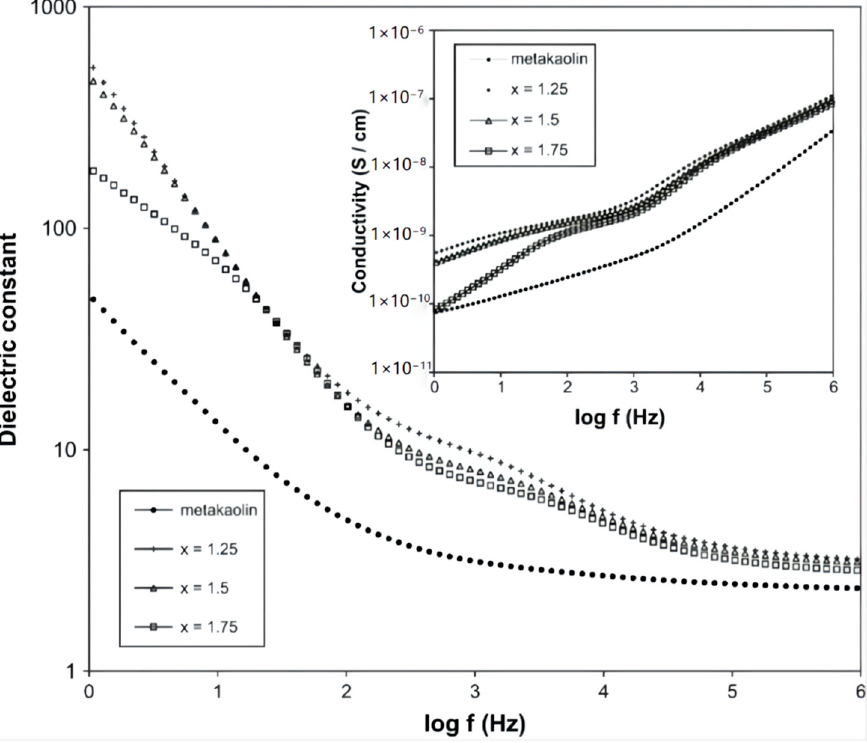
Figure 8. Dielectric permittivity and the inset show the conductivity of ASP geopolymers (x repre- sents the Si/P molar ratio) [19]. the Si/P molar ratio)